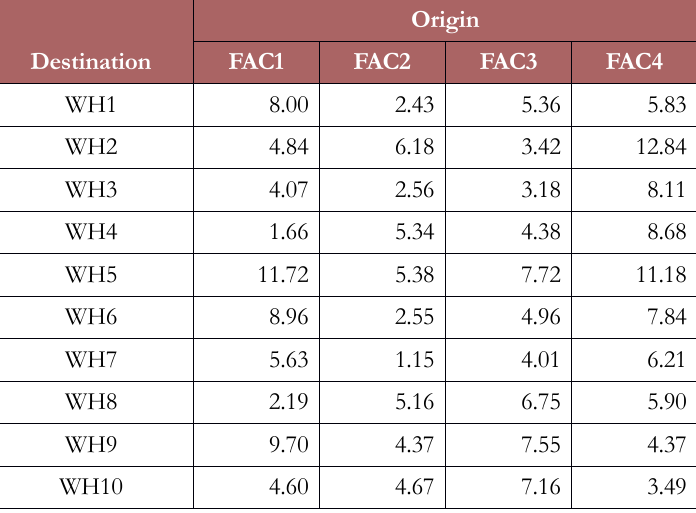
Table 5. Transportation costs from factories to warehouses Table 6 summarizes optimal solution for each period (P1, P2, P3)